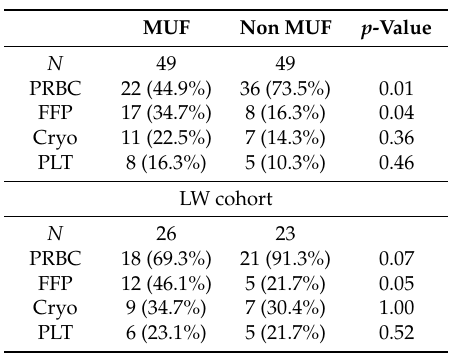
Table 4. Postoperative transfusion frequency.